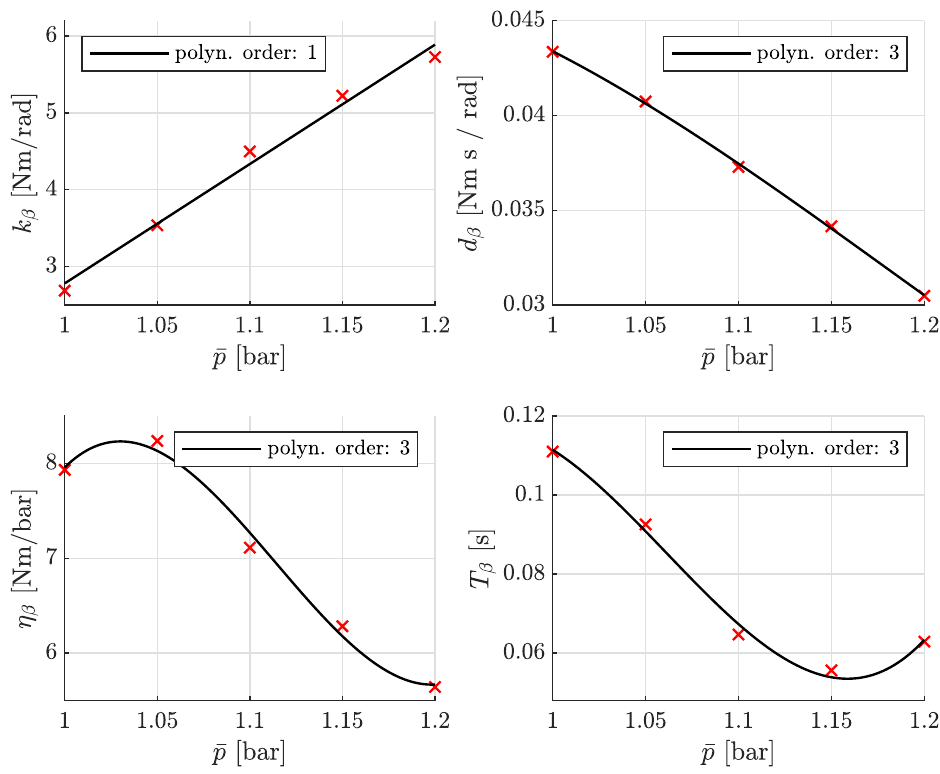
Figure A2. The parameters of the transfer function, G β ( s , ¯ p , m ) , as a function of the lower pressure level ¯ p . The red crosses indicate the parameter values from the identification experiments and the black solid lines show the first or third order polynomial